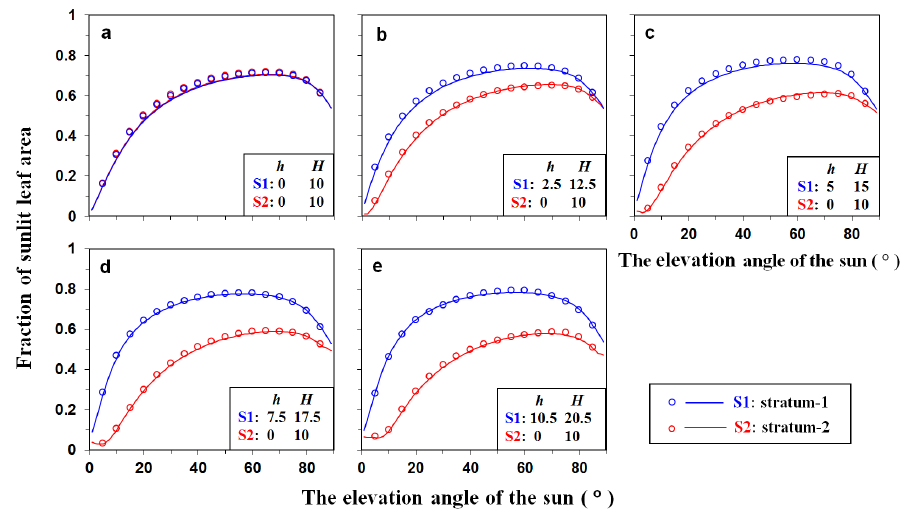
Figure 6. Comparisons of the calculated fractions of sunlit leaf area between the IPR model (curves) and the random approach (circles) for two-stratum plant communities of different heights (stratum-1 is shifted higher and higher). Blue and red colours are for stratum-1 (S1) and stratum-2 (S2), respectively. The top and bottom heights of the crowns ( h and H) were shown in each panel. Other parameters are the same (crown width D = 1m, local leaf area index LAI p = 3, plant density d = 0.2plantsm − 2 )